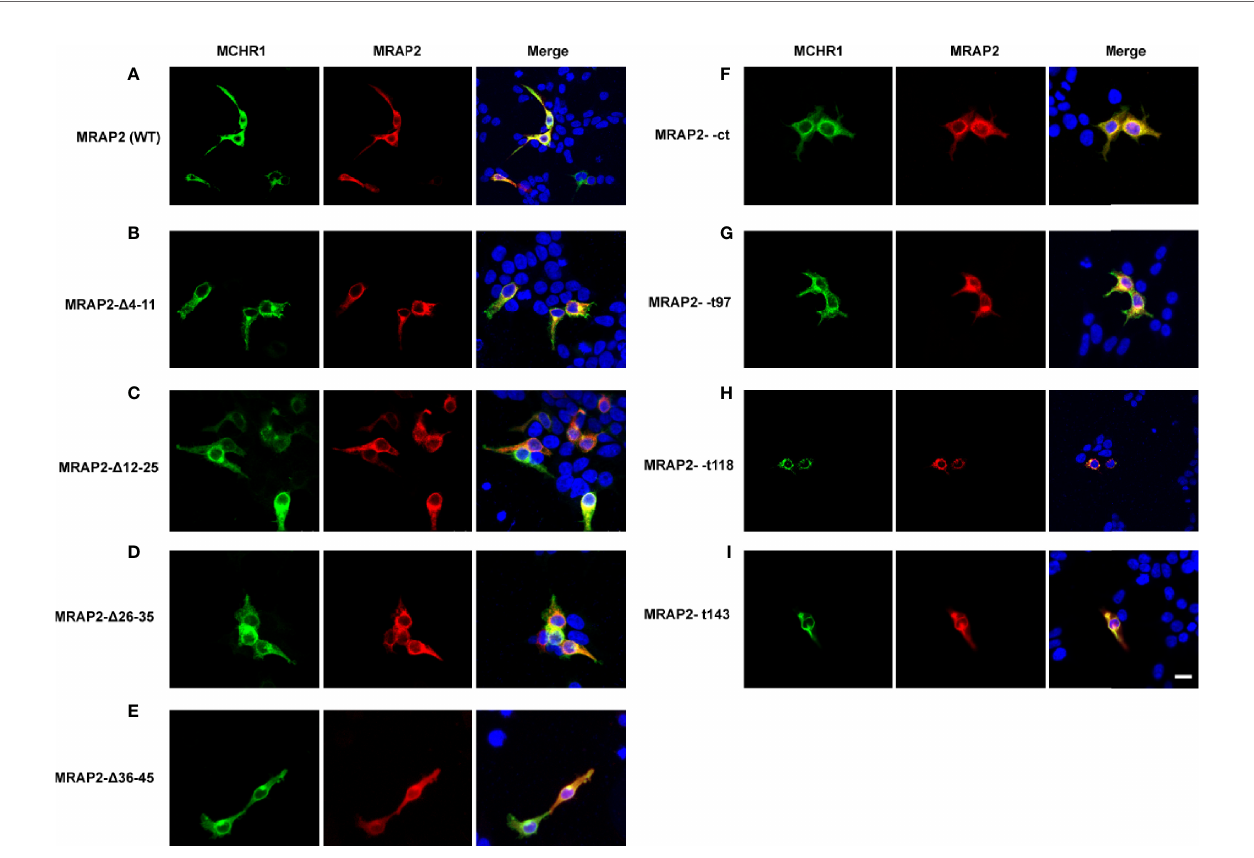
FIGURE 5 | Co-localization of MRAP2 mutants with MCHR1. (A) Confocal images of MCHR1 (green) when co-transfected with WTMRAP2 (red). (B – E) Localization of MCHR1 (green) when co-transfected with MRAP2 C-terminal mutants (red). (F – I) Images are co-transfected with MCHR1 (green) and MRAP2 N-terminal mutants. DAPI was used to stain cell nuclei and shown in blue. Merged images are shown in